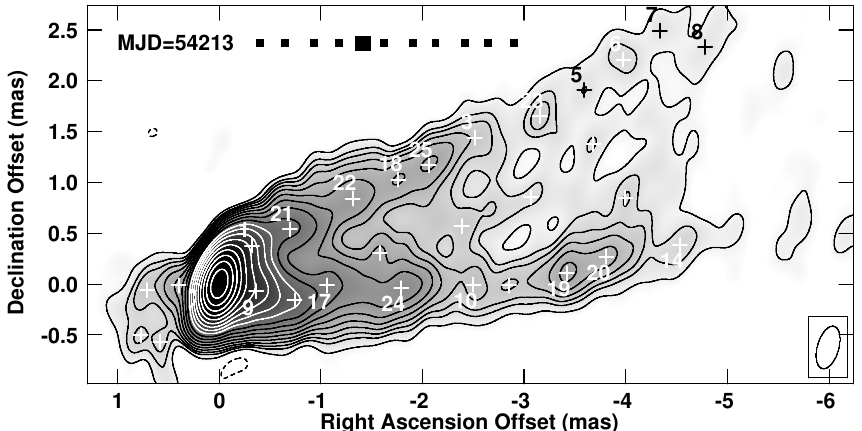
Figure 3. An example VLBA image of M87 at 43 GHz. This one is based on data taken on 23 April 2007. The lowest contours are at –1, 1, 2, 2.83, 4 mJy/beam increasing from there by factors of convolving beam is 0.43 × 0.21 mas elongated along position angle − 16 ◦ . The crosses mark positions of local maxima identified visually. Images like this were created, and examined for local maxima, for 23 epochs in 2007 and 2008. The numbers identify maxima that visual examination suggests can be identified at multiple, sequenctial epochs. All of the images will be shown in Walker et al.